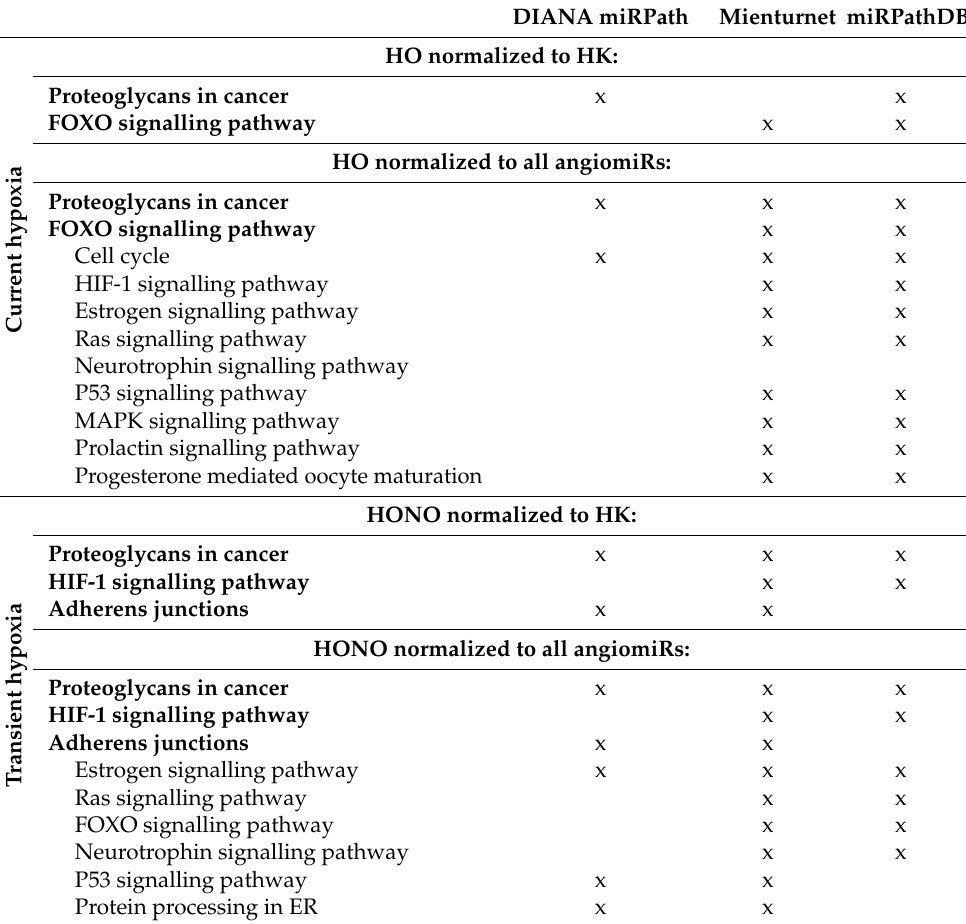
Pathways simultaneously identified when normalized to the geometric mean of housekeeping genes (HK) and when normalized to the geometric mean of all angiomiRs, are printed in